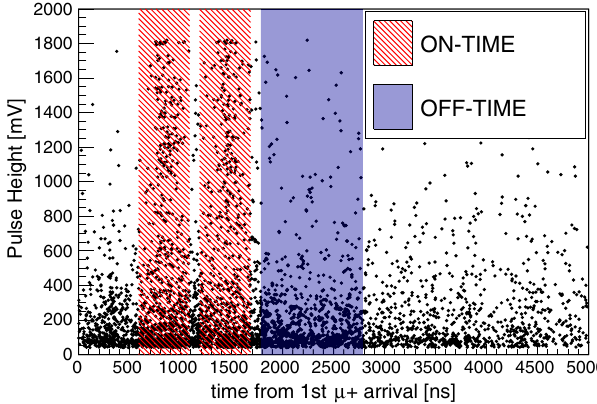
FIG. 8. TOF and pulse height distribution of the MCP signals of the BWM recorded using the